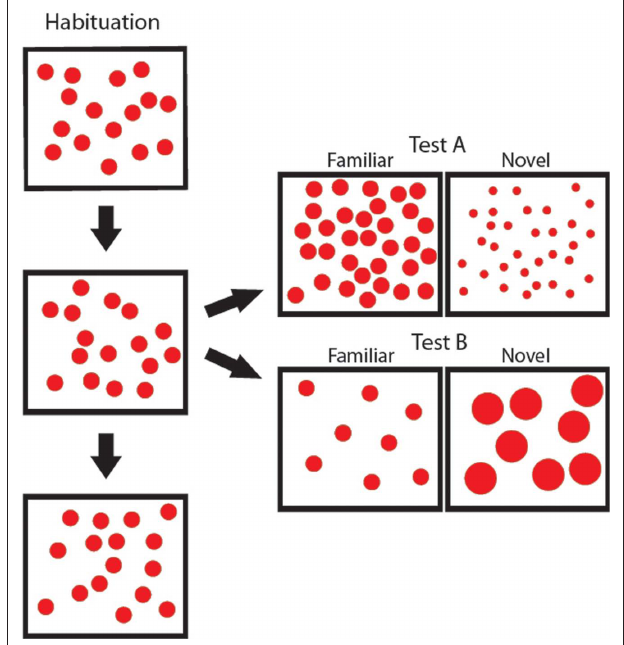
Figure 3 | Sample stimuli from experiment 2a. In habituation, the number of items in each display and the size of the items remained constant throughout habituation. In test, infants saw displays with the same item size and displays with items that changed in size fourfold from habituation.